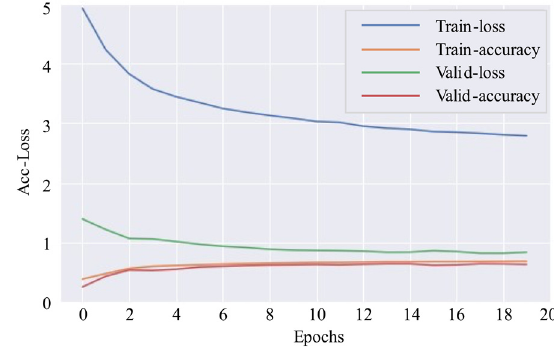
Figure 23. Learning curve (Bi-GRU) .